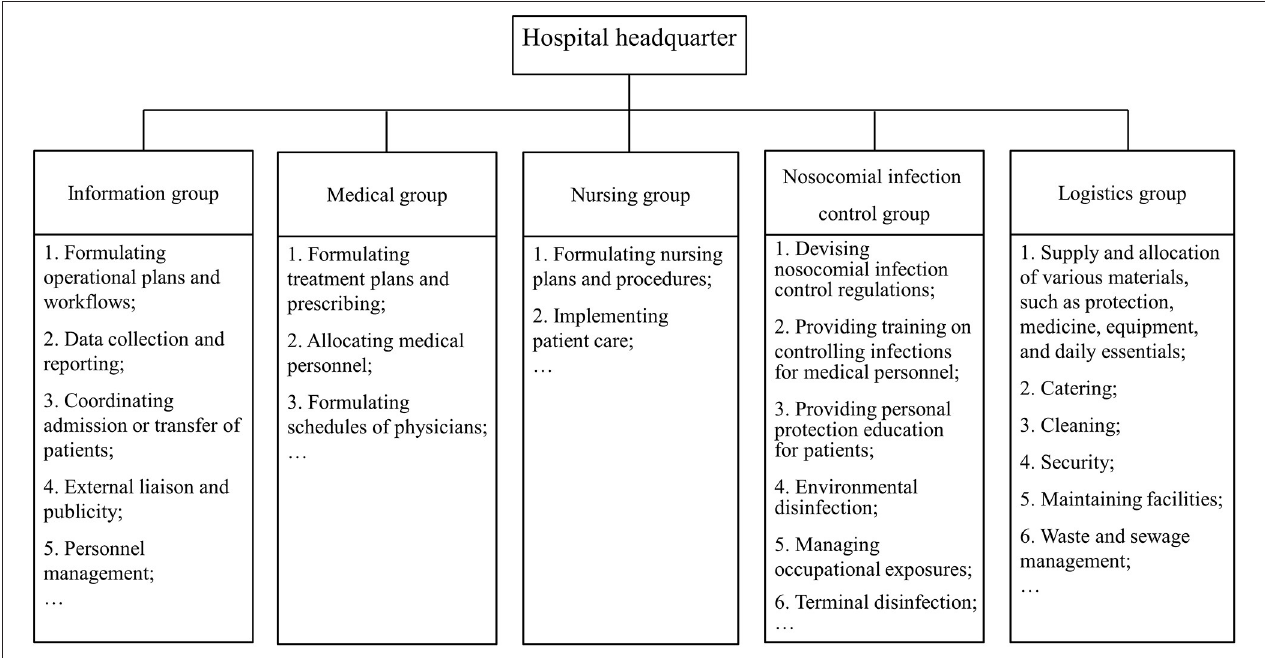
FIGURE 2 | Organizational structure of the mobile cabin